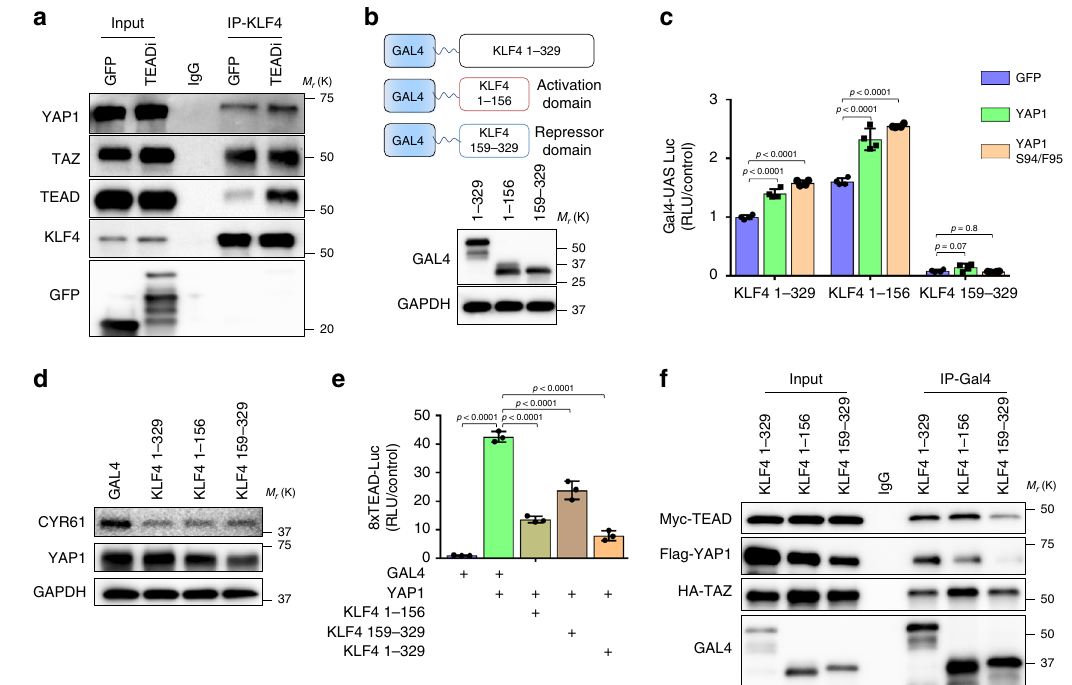
Fig. 4 KLF4 interacts with the YAP1/TAZ-TEAD complex. a Coimmunoprecipitation experiments in N/TERT2G cells transduced with TEADi or GFP. b Schematic representation of GAL4-KLF4 fusion proteins and western blot showing their expression in HEK293 cells. c Transcriptional activity of GAL4 DNA-binding domain fusion proteins measured by luciferase assay by UAS-Luc in HEK293 cells. d Western blot analysis of the expression the indicated markers in HEK293 cells transduced YAP1 in combination with the indicated GAL4 fusion proteins for 48 h. e Transcriptional activity of TEAD in HEK293 cells transduced with YAP1 and GAL4-KLF4 fusion proteins or GAL4 control. f Coimmunoprecipitation experiments in HEK293 cells transduced with the indicated GAL4-KLF4 proteins and Myc-tagged TEAD, HA-tagged TAZ and FLAG-tagged YAP1. In c n = 4 biological replicates; in e n = 3 biological replicates. Mean ± SD is shown; one-way ANOVA with Dunnett ’ s multiple comparisons test. Source data are provided as a Source Data fi